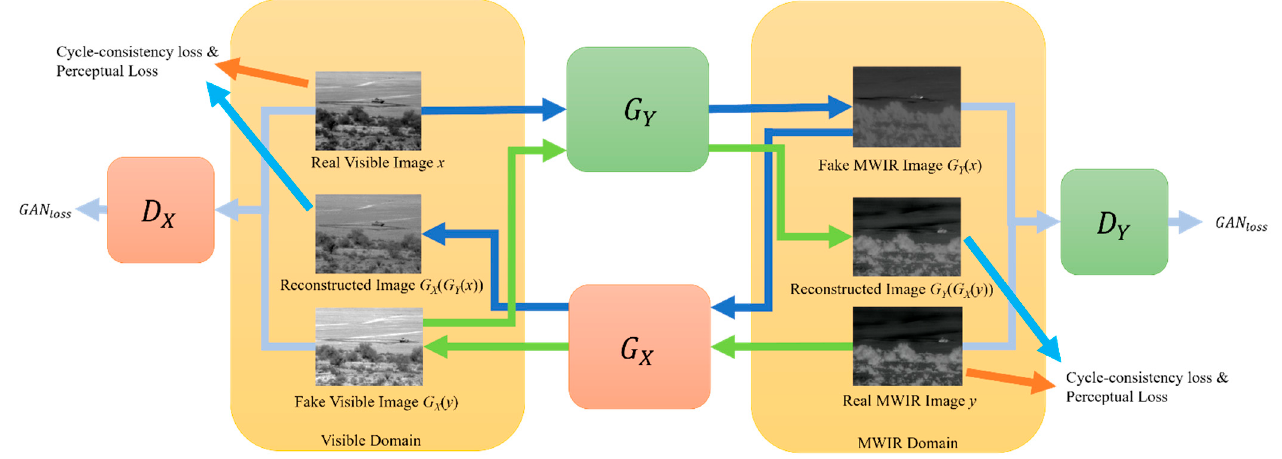
Figure 1. Framework of the proposed model for converting visible images to MWIR images. Our proposed model has two generators and two discriminators. We calculate the cycle-consistency loss and the perceptual loss using the real images (x, y) and the reconstructed images ( G X ( G Y ( x )), G Y ( G X ( y ))) along with the GAN loss during training our model. Arrows with different colors indicate signal flows through the generators and discriminators.